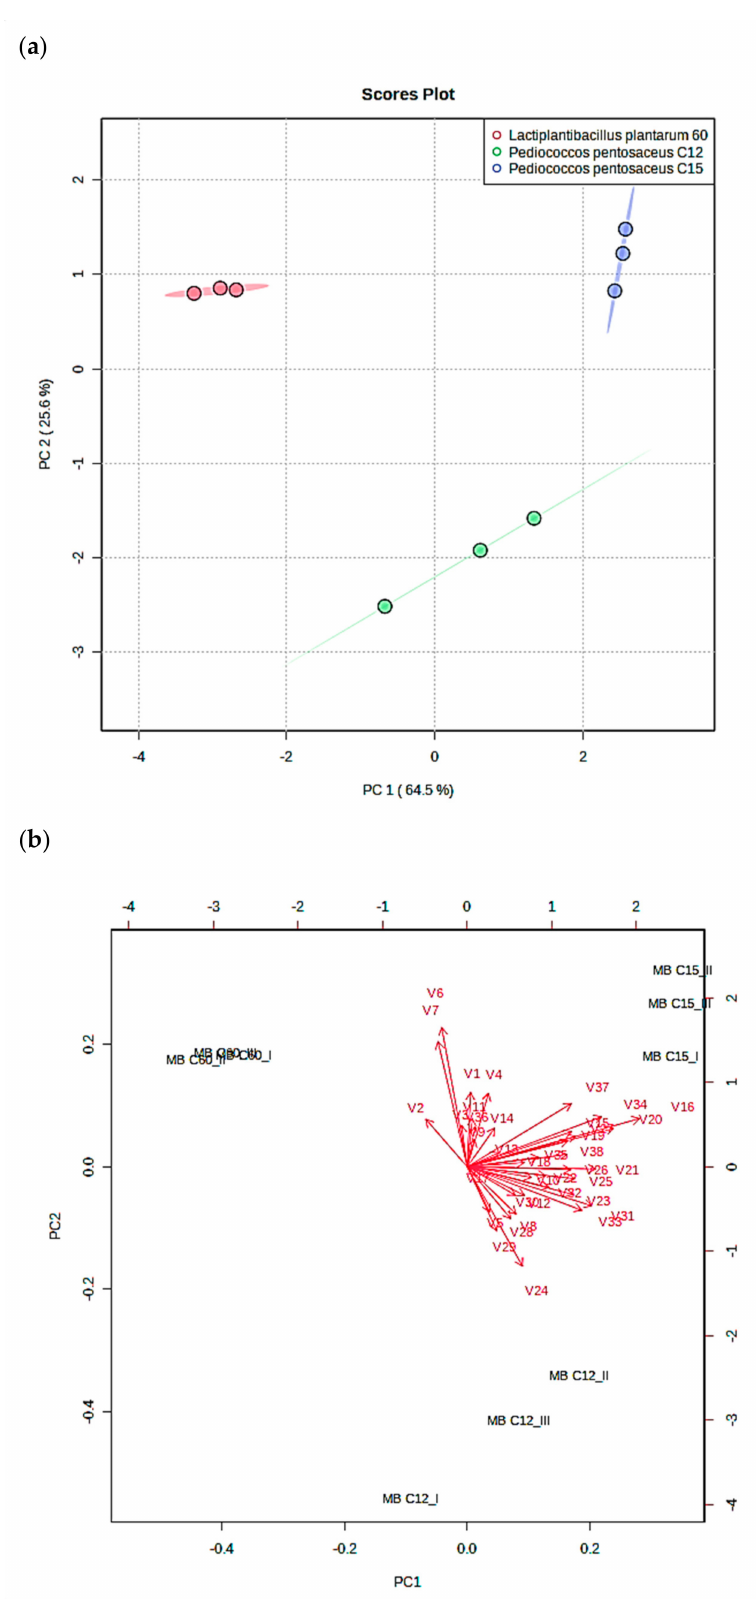
Figure 4. Principal component analysis (PCA) scores plot of the bioactive compounds (organic acids, phenolic acids, and volatile organic compounds) found in the meat broth fermented by P. pentosaceus C12 (MB C12), P. pentosaceus C15 (MB C15), and L. plantarum C60 (MB C60) ( a ) and relative loadings of the variables employed ( b